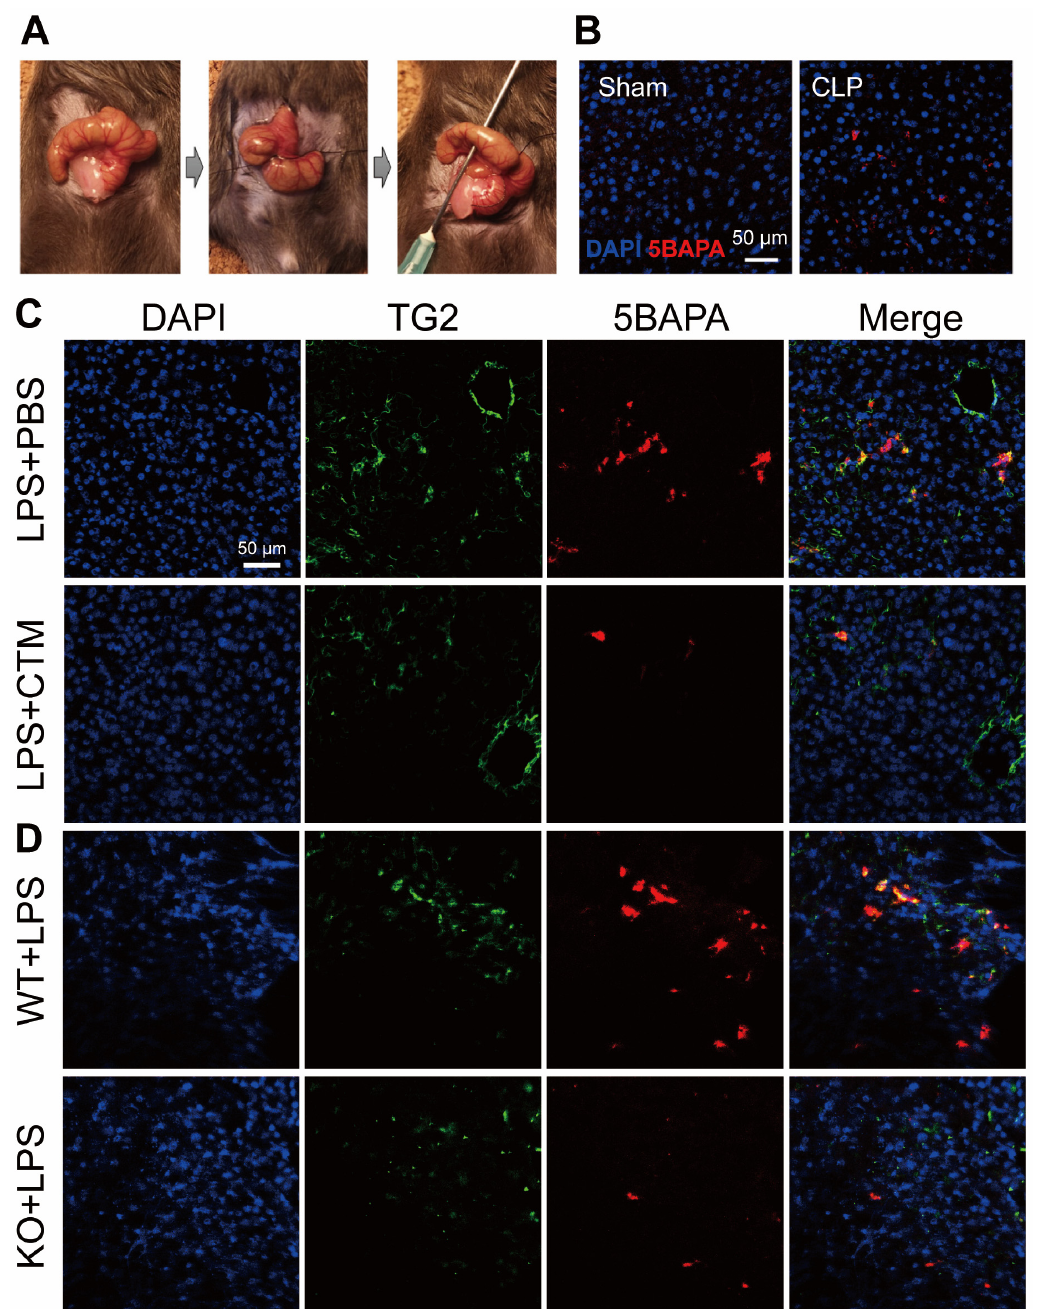
Figure 3. TG2 activity in the liver of septic mice. ( A ) Representative images from the cecal ligation and puncture (CLP) procedures. ( B ) TG2 activity in the liver of CLP-operated mice. Immunofluorescence staining with 4 ′ ,6-diamidino-2-phenylindole (DAPI) (blue) and 5-biotinamidopentylamine (5BAPA) (red) in frozen liver sections obtained from mice 48 h after sham or CLP operations. Scale bar: 50 µ m. ( C ) TG2 activity in the liver of lipopolysaccharides (LPS)-injected mice. Immunofluorescence staining with DAPI (blue), TG2 (green), and 5BAPA (red) in frozen liver sections obtained from mice injected intraperitoneally with LPS in the presence and absence of CTM. Scale bar: 50 µ m. ( D ) TG2 activity in the liver of LPS-injected TG2 knockout (KO) mice. Immunofluorescence staining of DAPI (blue), TG2 (green), and 5BAPA (red) in frozen liver sections obtained from mice injected intraperitoneally with 10 mg/kg LPS for 24 h. Scale bar: 50 µ m. These images have been adapted from a previous study